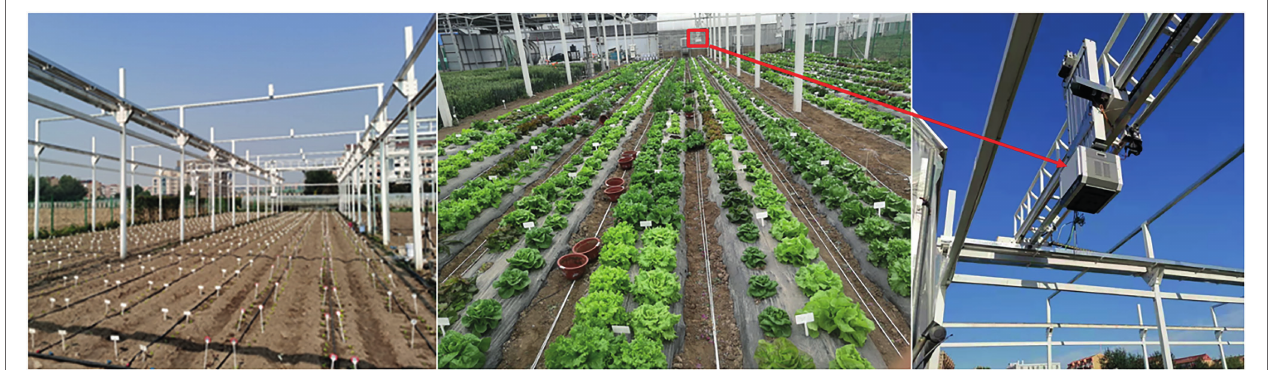
FIGURE 1 | Picture of plants and LQ-FieldPheno in the